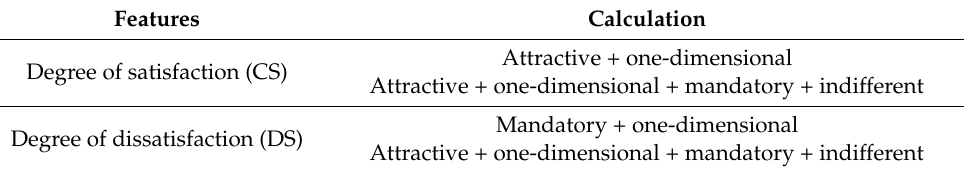
Table 2. Calculation of the degree of satisfaction and dissatisfaction using the Kano model.